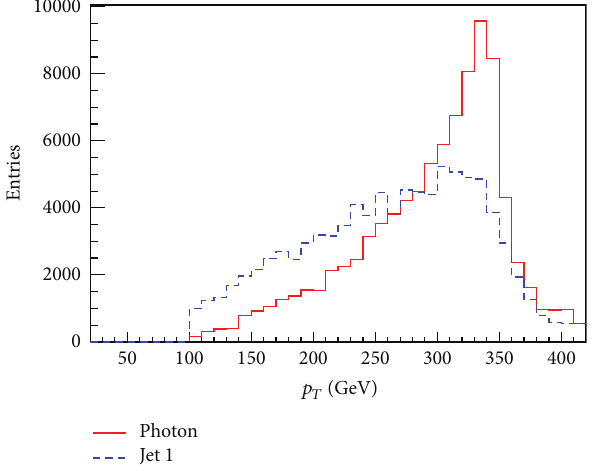
Figure 17: Transverse momentum distributions of leading jet and photon ( 𝑏𝛾 production) for signal after detector simulation.